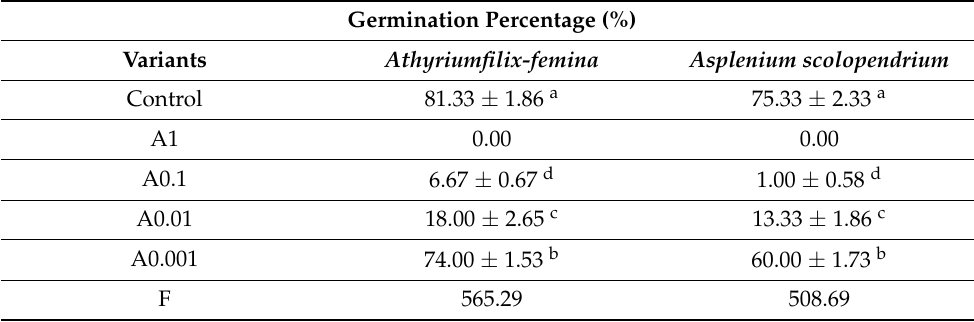
Table 3. Influence of Actellic 50 EC on spore